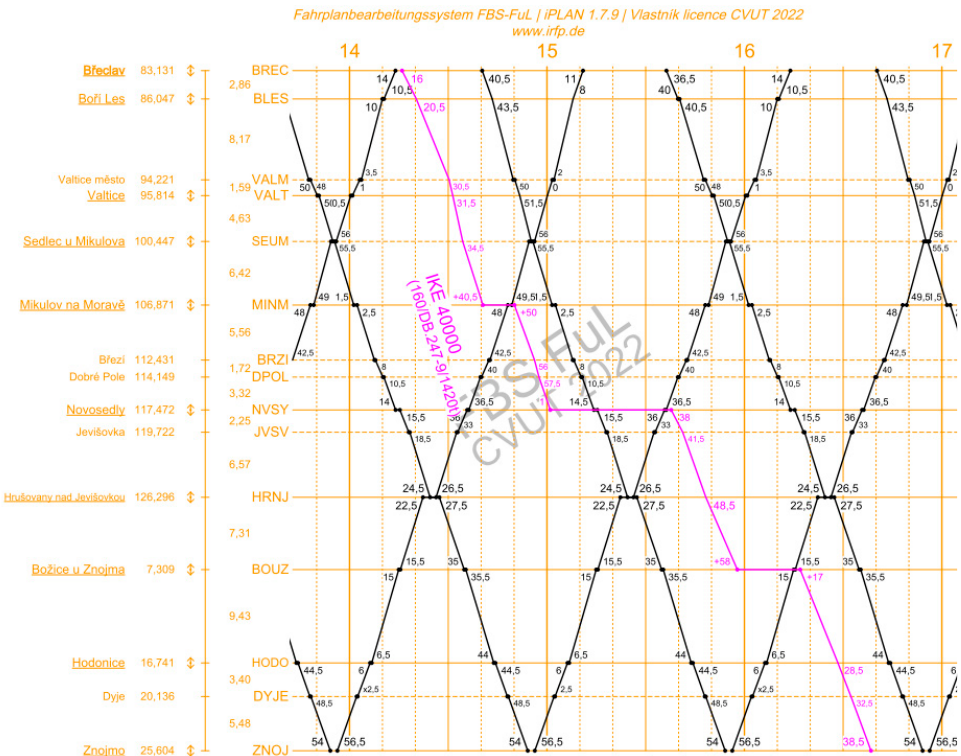
Figure 6. Proposed freight train path on the rail line 246—direction to Znojmo (data: [1,27]). Source: Authors.